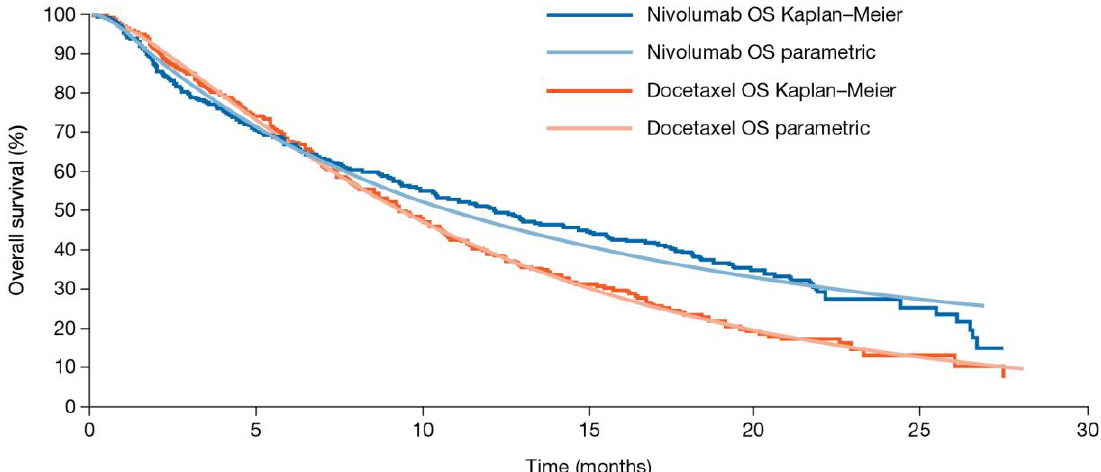
Figure 4: Parametric curves for OS over 30 months (non-squamous analysis; CheckMate 057) OS = overall